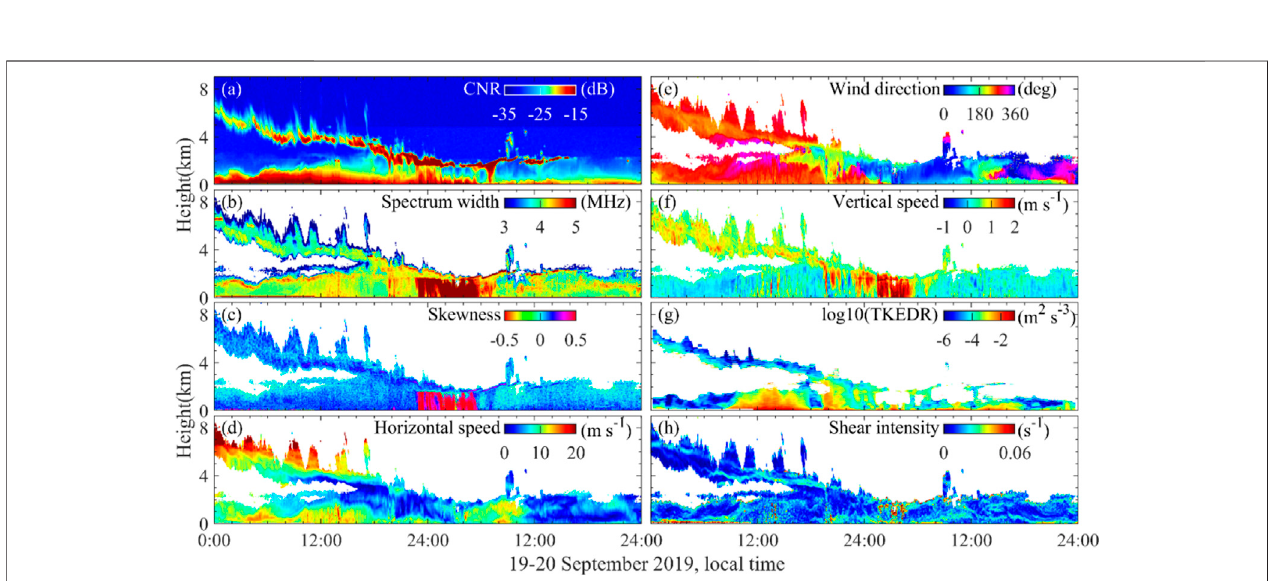
FIGURE 6 | A precipitation process observed by the C-DWL during September 19 – 20, 2019. (A) CNR, (B) spectrum width, (C) skewness, (D) horizontal wind speed, (E) horizontal wind direction, (F) vertical wind speed, (G) log10 (turbulent kinetic energy dissipation rate, TKEDR), and (H) shear intensity.